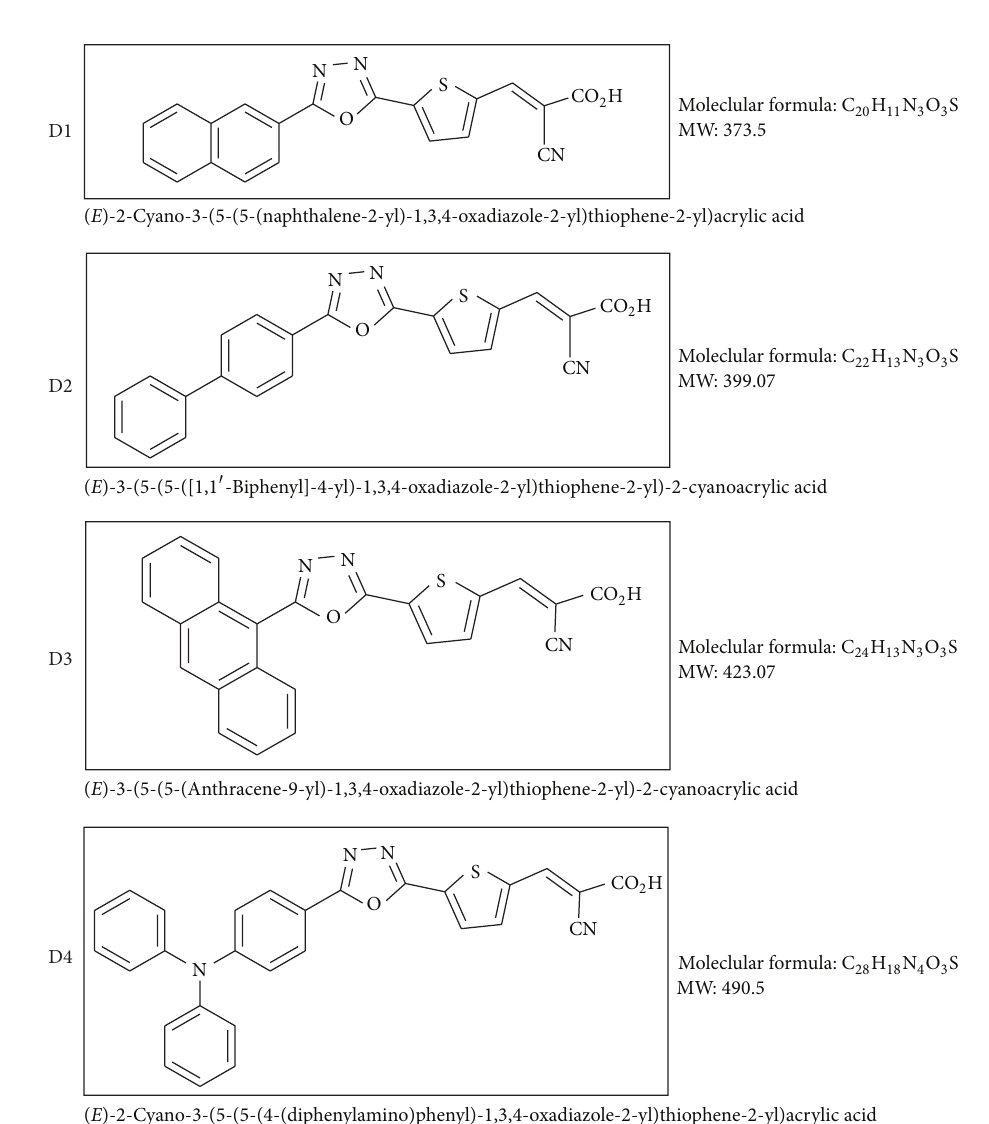
Figure 1: Structures of the novel 1,3,4-oxadiazole based